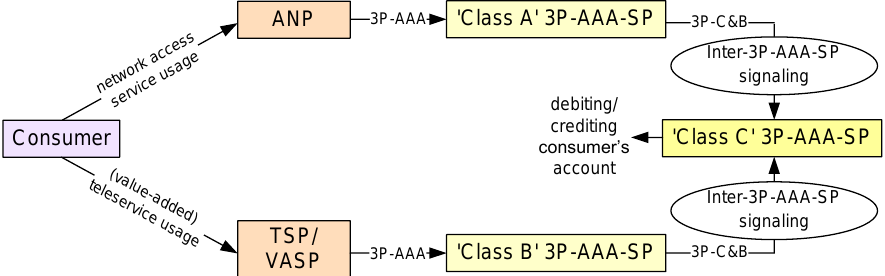
Figure 9. An illustration of the Inter-3P-AAA-SP signaling operations and flows (an update from